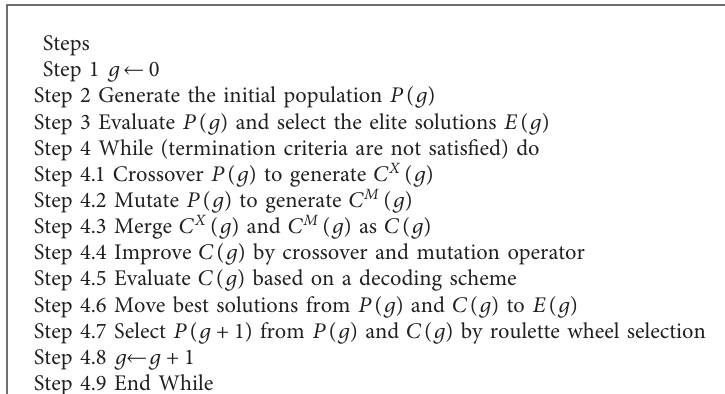
Figure 5: Impacts of the GA parameters on solutions. (a) Objective value of GA. (b) Tuning of stall generation. (c) The effect of population sizes ( ρ ) on makespan versus computation time. (d) The outperformed regions of combinations of crossover fraction and mutation